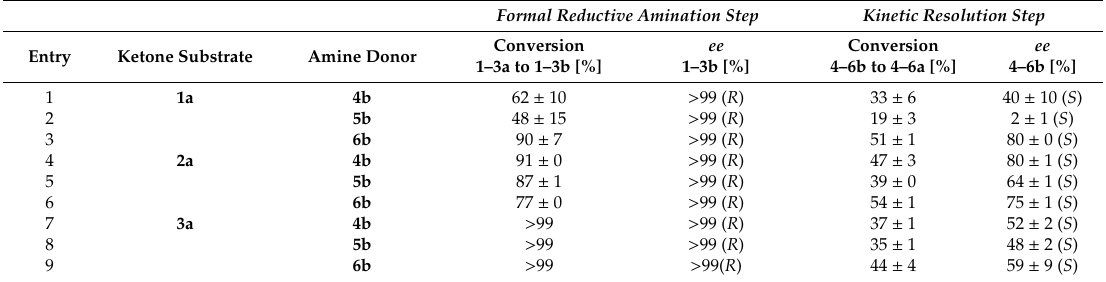
Table A1. Screening of substrate ketones ( 1 – 3a ) and amine donors ( rac - 4 – 6b ) in the PIKAT.